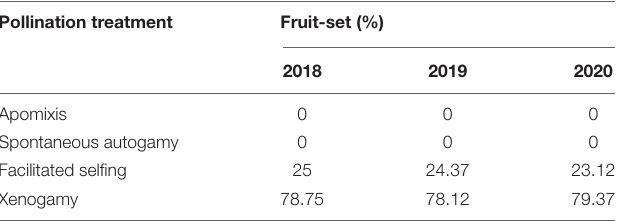
Pollination treatment Fruit-set